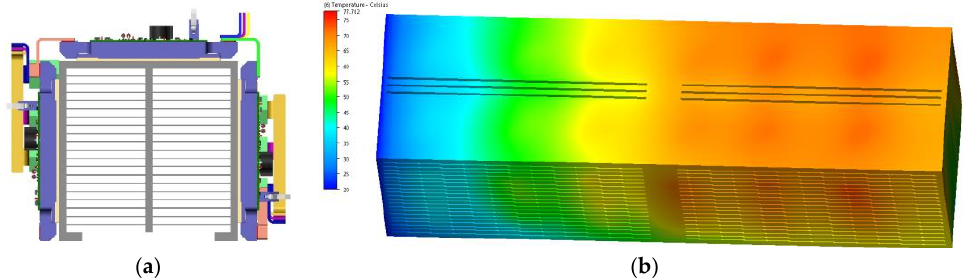
Figure 9. ( a ) Improved heatsink version II; and ( b ) its FEA results (maximum temperature on the